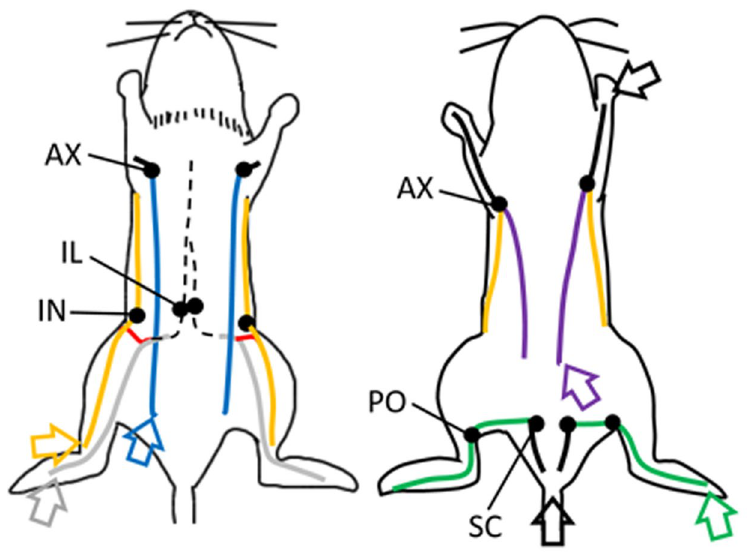
Figure 2. Schematic drawing of the lymphatic system related to the drainage of lymph fluid in the hindlimb of mice. This figure was based on results obtained from lymphography and the dissection of mice. Black circles; lymph nodes (LNs), dashed black lines; lymphatics in the intra-abdomen or intrathoracic area, black solid lines; lymphatics in subcutaneous tissue or muscle on the upper limb or buttock, green solid lines; the superficial lateral system corresponding to open and closed green arrowheads in Fig. 1a, yellow solid lines; the superficial medial system corresponding to open and closed yellow arrowheads in Fig. 1b, gray solid lines; the deep medial system corresponding to open and closed white arrowheads in Fig. 1c, red solid line; lymphatics that started at the level of the inguinal region and ran into the iliac LN corresponding to closed red arrowheads in Fig. 1c, blue solid lines; lymphatics that started at the lower abdomen and ran into the axillary LN corresponding to open blue arrowheads in Fig. 1d, purple solid lines; lymphatics that started from the lower back and ran into the axillary LN corresponding to open purple arrowheads in Fig. 1e. Open green arrow; the injection site of dyes that visualized the superficial lateral system, open yellow arrow; the injection site of the dyes that visualized the superficial medial system and lymphatics revealed by red solid lines, open gray arrow; the injection site of the dyes that visualized the deep medial system. The open gray arrow is the same site as the open green arrow. Left figure; supine position, right figure; prone position. IN; inguinal LN, AX; axillary LN, IL; iliac LN, PO; popliteal LN, SC; sciatic